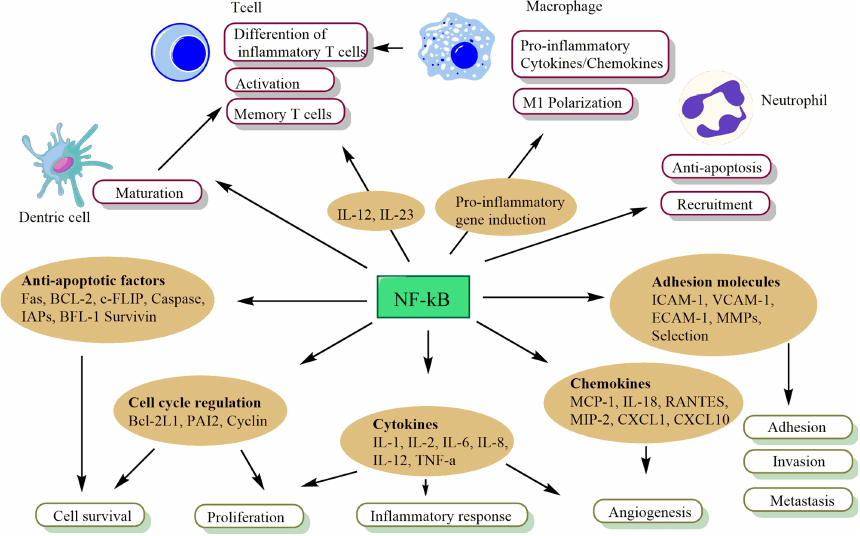
Figure 1. Nuclear factor kappa-B and inflammatory response (Adapted from Ref. 7).